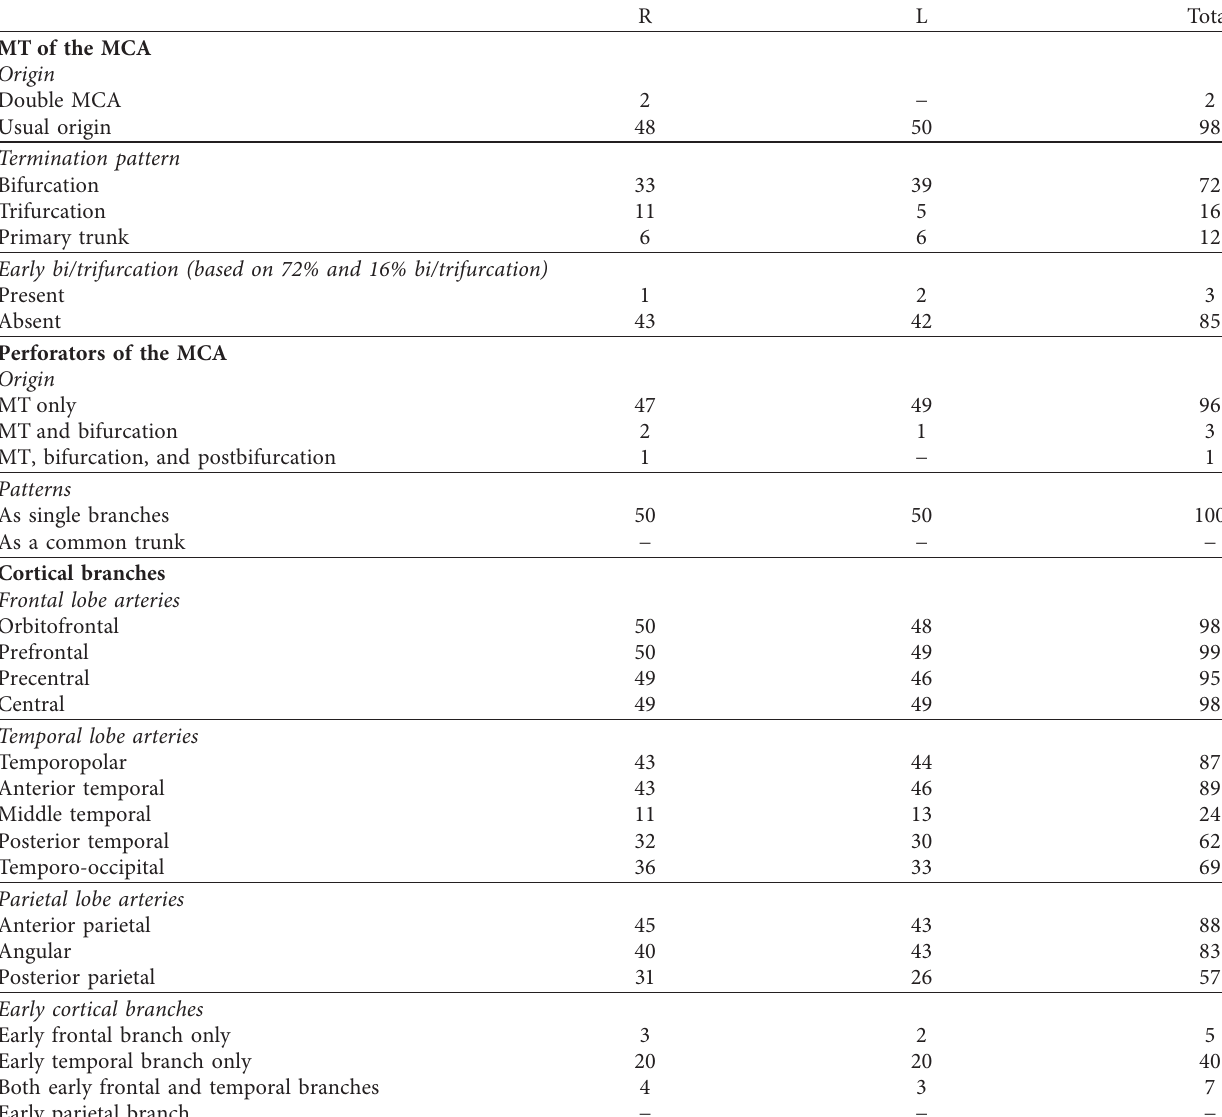
Table 1: Main trunk, perforators, and cortical branches of the